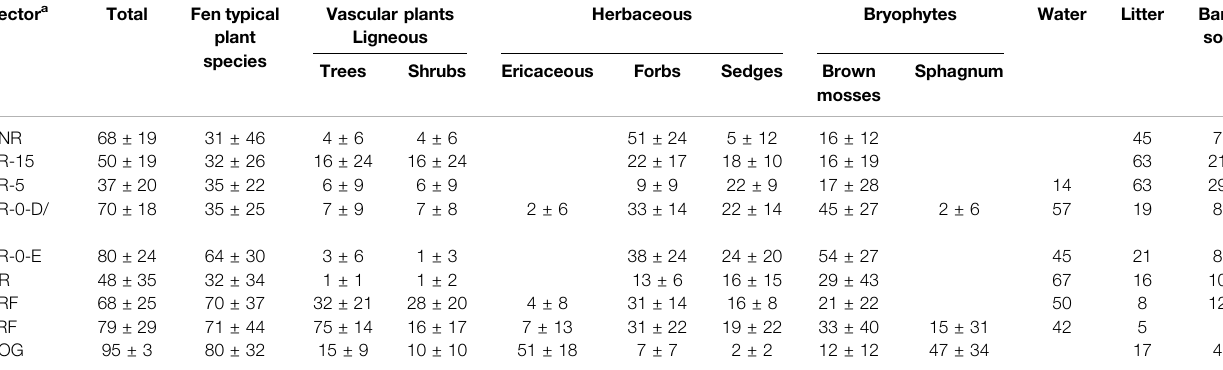
TABLE 4 | Mean cover ( ± SD) in % for plant functional types, water, litter and bare soil (mineral soil or peat), as surveyed in August 2017 and 2018 in all monitoring sectors. Sector a